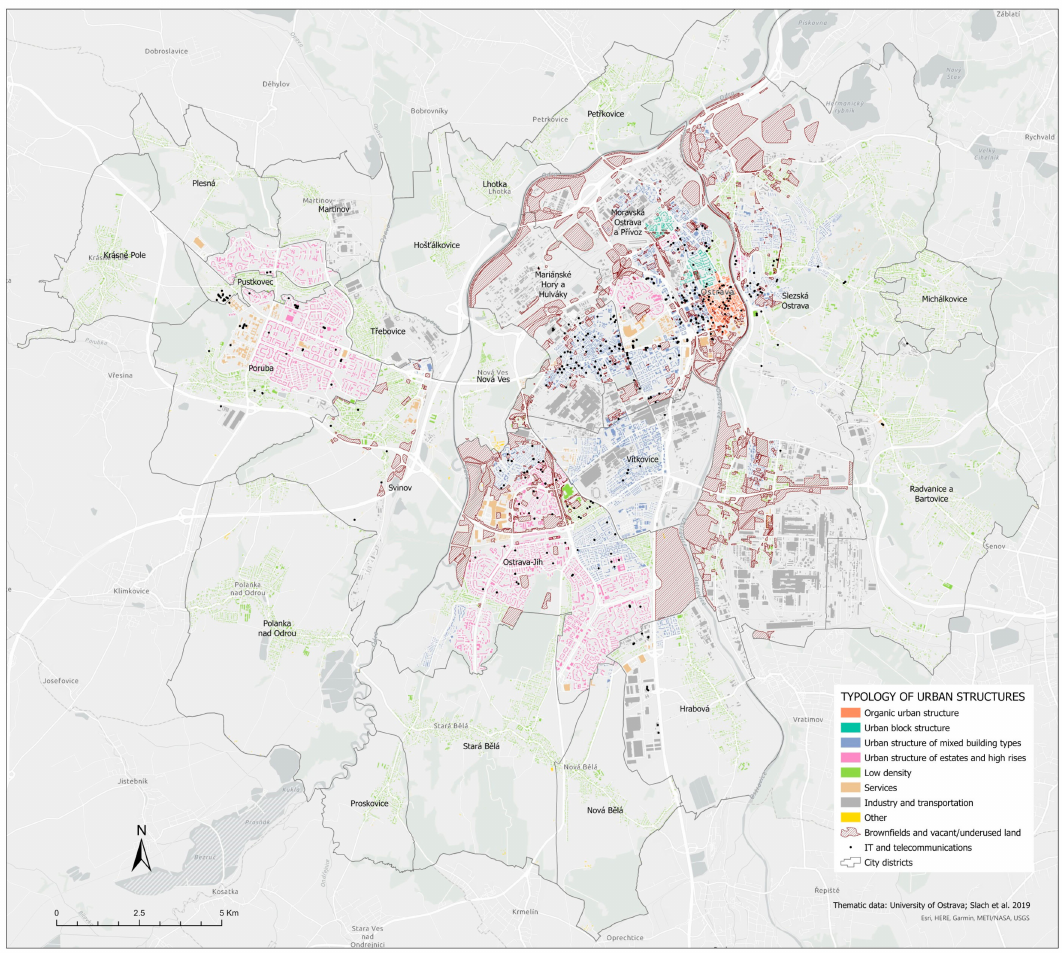
Figure 12. ICT firms in Ostrava and urban